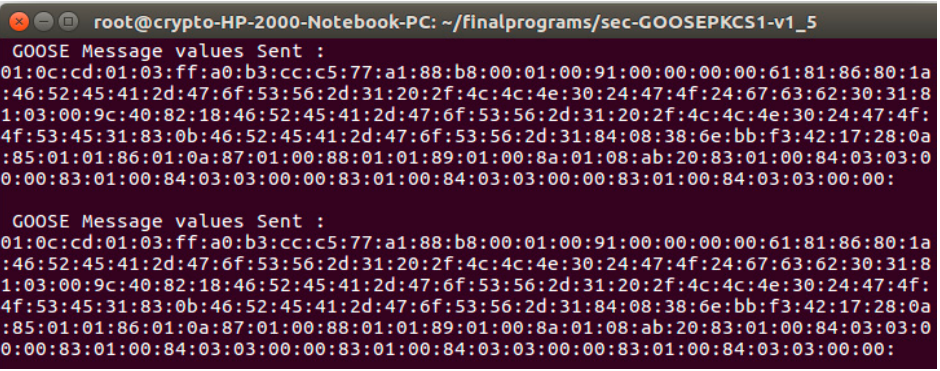
Figure 10. GoSV software program sending custom GOOSE frames.